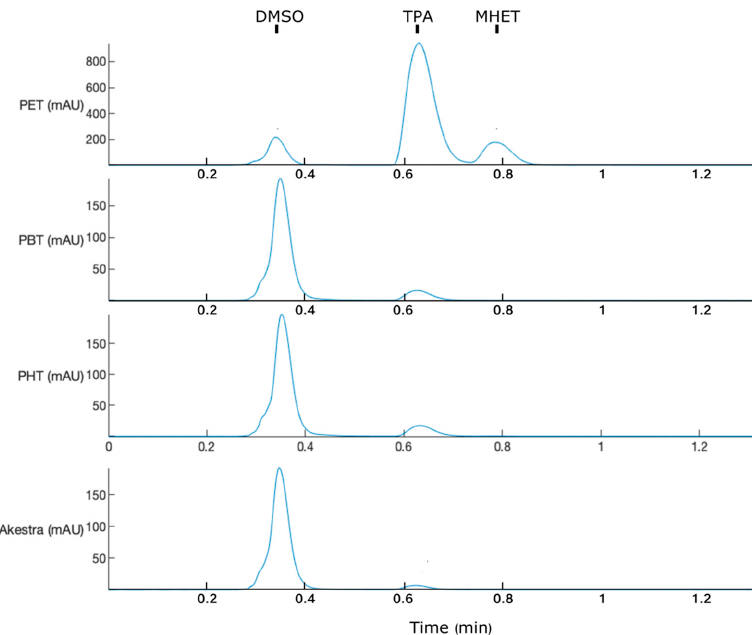
Figure 7. HPLC analysis of Is PETase depolymerization of terephthalate polyesters after 72 h: poly(eth- ylene) terephthalate (PET), poly(butylene) terephthalate (PBT), poly(hexamethylene) terephthalate PHT), and Akestra™. Table 3. Depolymerization of different terephthalate polyesters after 72 h with an Is PETase/sub- strate ratio of 0.01 (mg/mg). Terephthalate Aromatic Polyester Degradation Products (mg/L) Depolymerization (%) PET 3934 39.34 PBT 25 0.25 PHT 12.5 0.13 Akestra™ 13.3 0.13